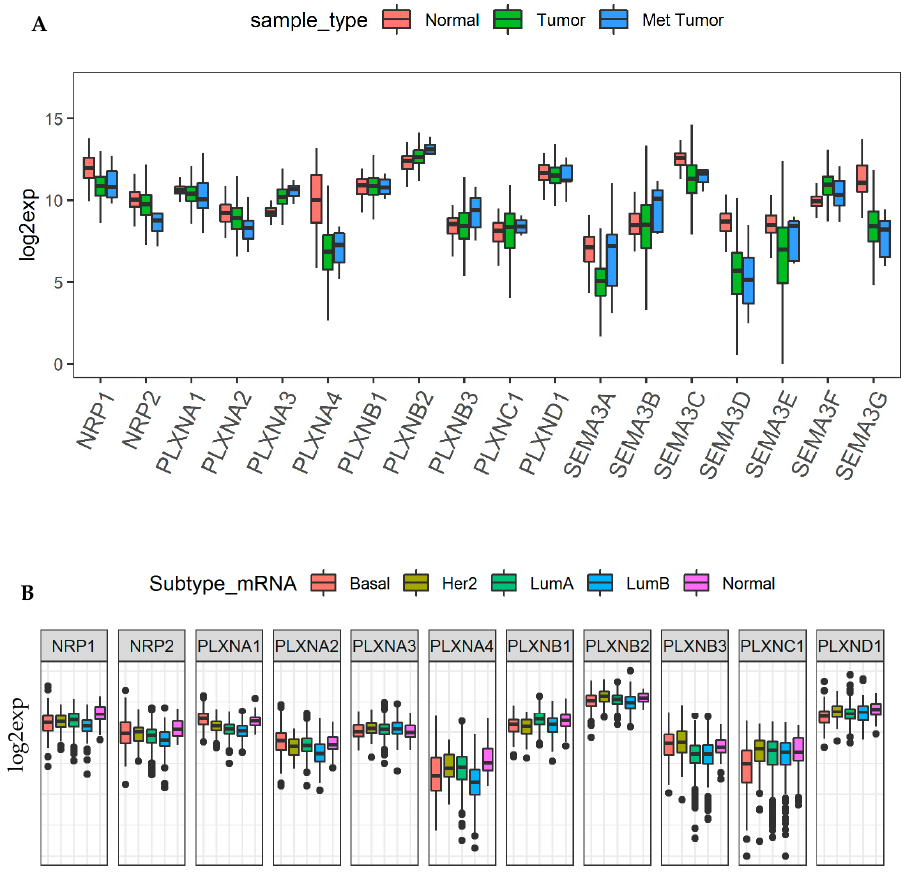
Figure 6. NRPs and PLXNs in breast cancer tumors and di ff erent molecular subtypes. ( A ). Box plots to show the expression of SEMA3s and their receptos NRPs and PLXNs in primary tumors ( n = 1095), metastatic tumors ( n = 7), and adjacent normal tissue samples ( n = 113) of the TCGA breast cancer cohort (BRCA). Linear mixed effects models were used for testing. ( B ). Association of NRP and PLXN gene expression with breast cancer molecular subtypes ( p < 0.0001) tested with ANOVA. p < 1/(18 genes × 3 comparisons) = 0.018 and <1/(11 genes × 5 subtypes) = 0.015 was considered as significance for A and B, respectively.